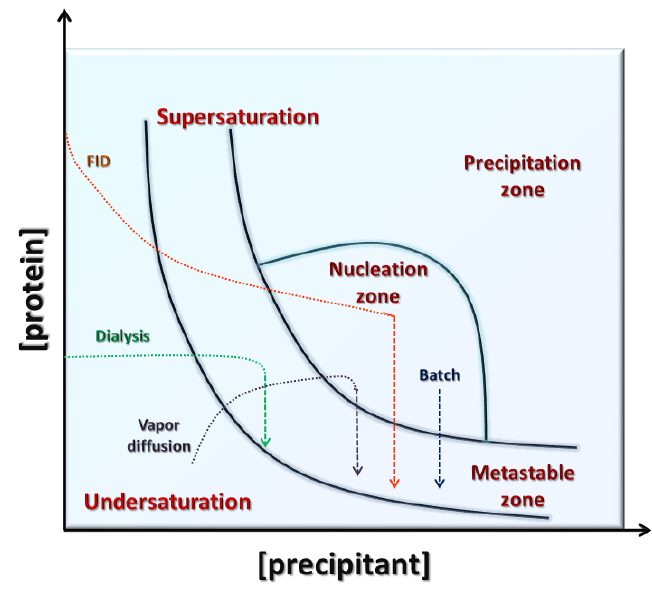
Figure 3. A simplified protein crystallization phase diagram. The different routes of reaching nucleation and metastable zones for the four main crystallization techniques are also